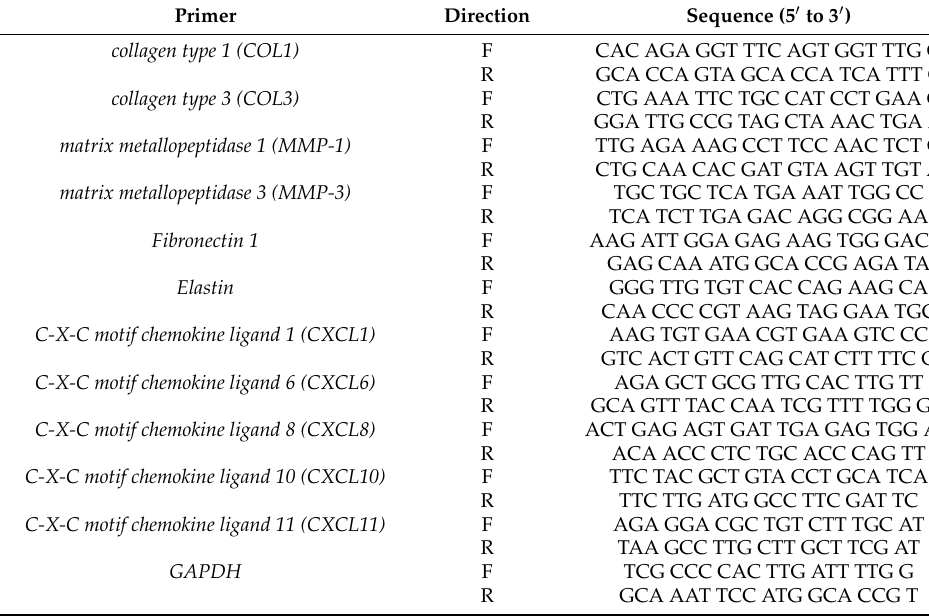
Table 1. Sequences of oligonucleotide primers for quantitative